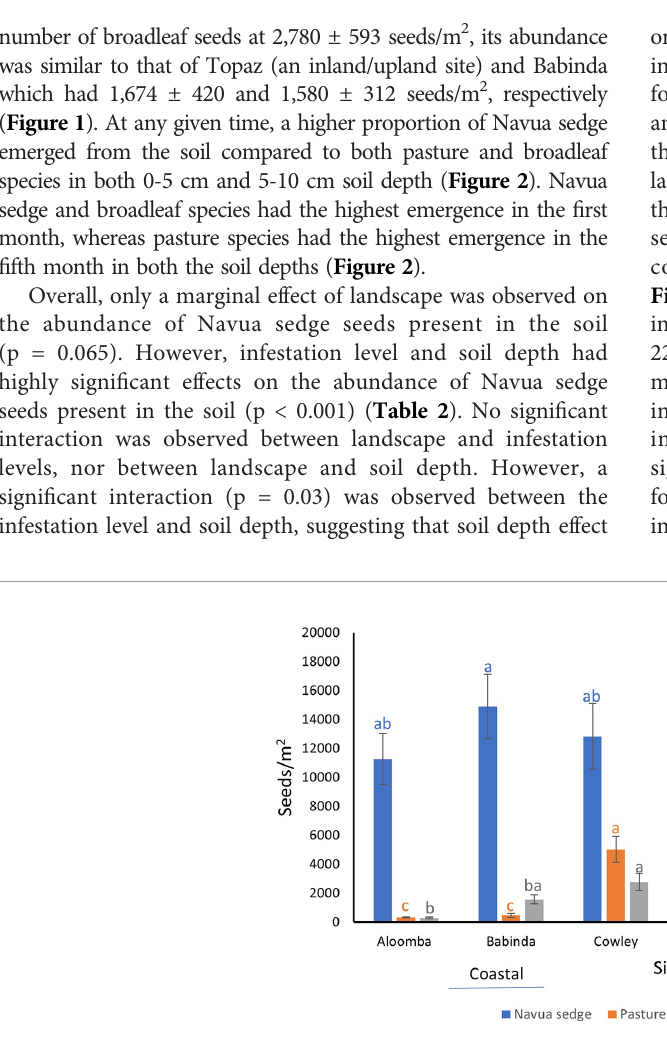
FIGURE 1 | Abundance of Navua sedge (blue), pasture (orange) and broadleaf (grey) seeds/m 2 in all the sites (mean ± standard error). Aloomba, Babinda and Cowley are coastal sites, while Tarzali, Topaz and Atherton are inland/upland sites. N= 4-6 plots per site; Abundance of seeds present is averaged across both the high and low infestation plots and the 0-5 cm and 5-10 cm soil pro fi le. Same letters for each category of seeds indicate means are not statistically different at p < 0.05 when tested with Tukey ’ s HSD test.